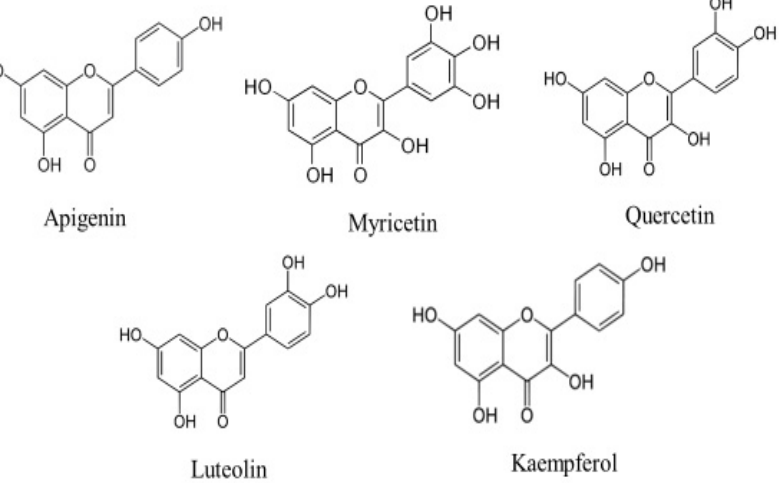
Figure 1. Chemical structures of flavonoids, such as apigenin, myricetin quercetin, luteolin and kaempferol.